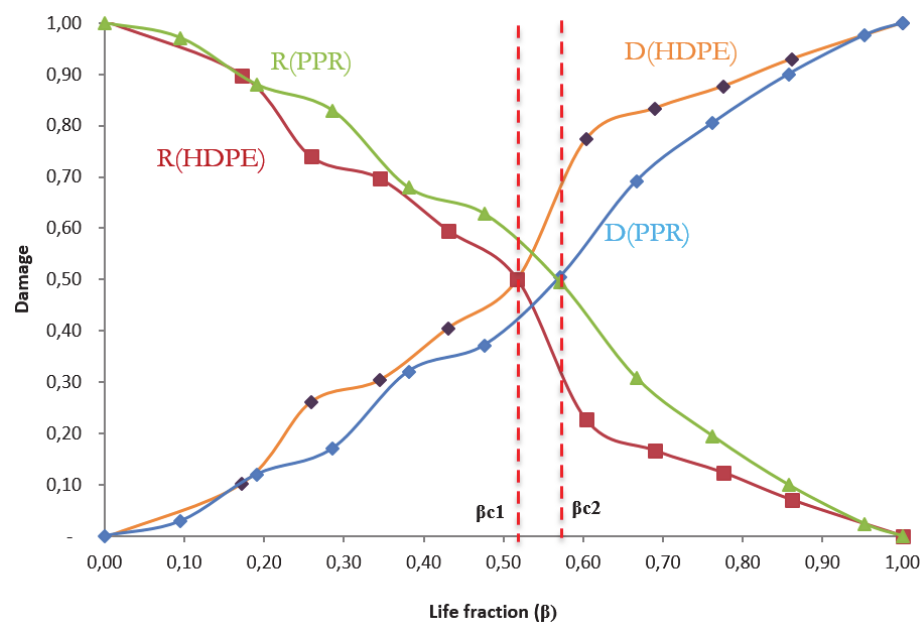
Figure 6 : PPR and HDPE’s damage-reliability evolution in function of the life